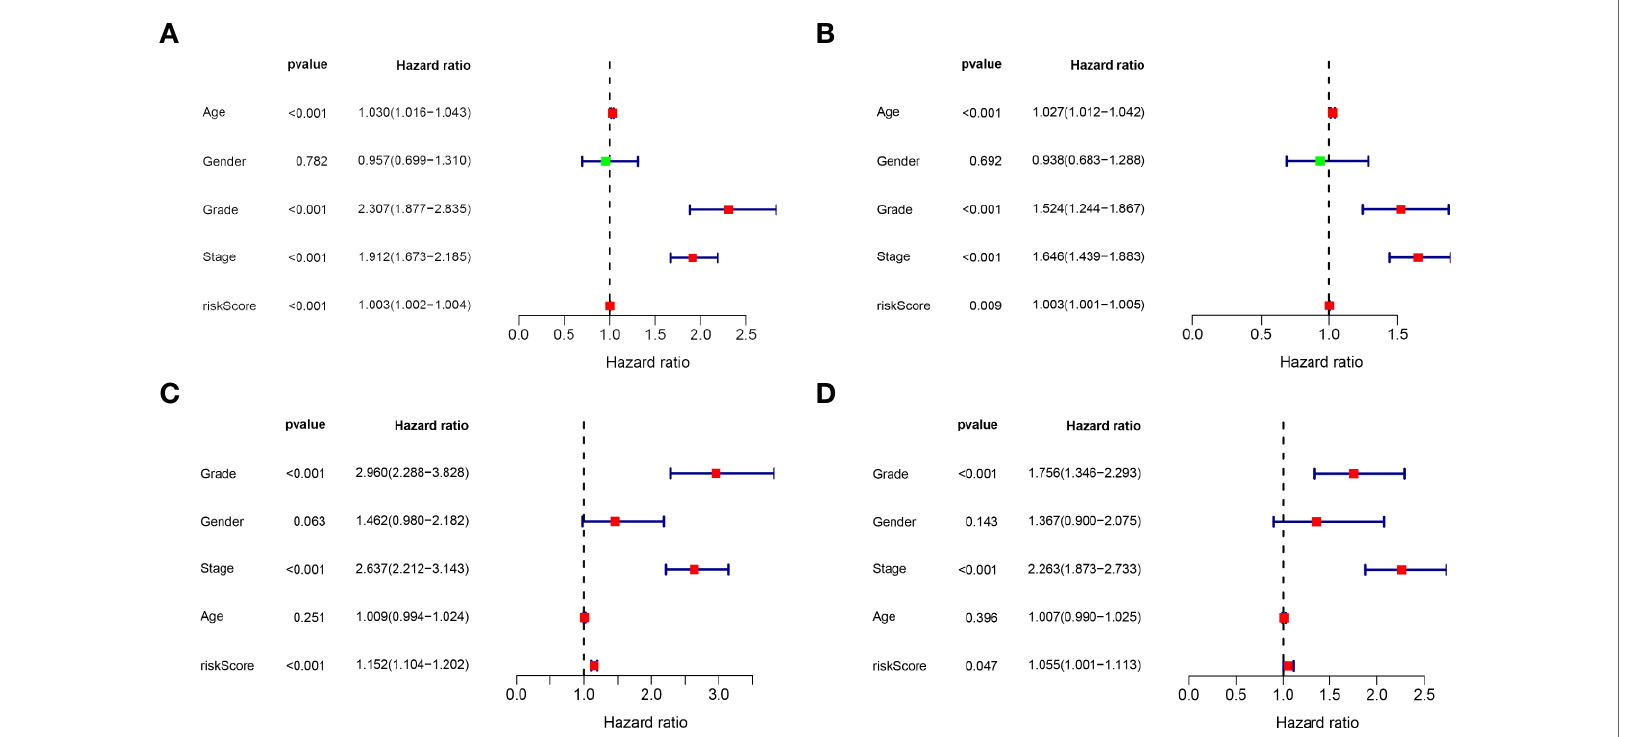
FIGURE 4 | Univariate cox regression analysis and multivariate cox regression analysis of the association between EMT-related lncRNA signature and clinical factors in the OS (A , B) and DFS (C , D) ,